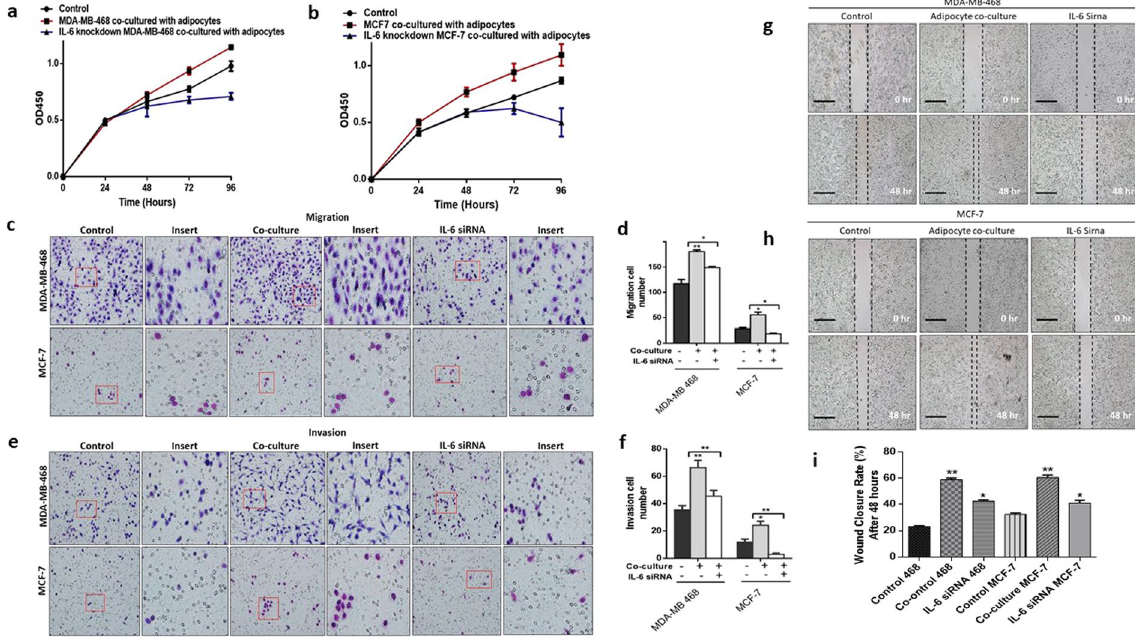
Figure 6. Blocking IL-6 signals reverses human adipocytes induced aggressive characteristics of breast cancer. ( a,b ) Proliferation capabilities of co-cultured breast cancer cells assessed in co-cultured breast cancer cells with/without IL-6 neutralization and in control cells. ( c ) Migration rate was examined using the transwell insert without matrigel in co-cultured breast cancer cells with/without IL-6 neutralization and in control cells. ( d ) Quantification of migration capabilities ability of in co-cultured breast cancer cells with/without IL-6 neutralization and in control cells. ( e ) Invasion rate in co-cultured breast cancer cells with/without IL-6 neutralization and in control cells. ( f ) Quantification of invasion capabilities in co-cultured breast cancer cells with/without IL-6 neutralization and in control cells. ( g, h ) Representative images of wound healing assay. Breast cancer cell motility accessed by a wound healing assay after 48 hours (magnification, x100), MDA-MB-468 and MCF-7 co-cultured breast cancer cells had a higher motility rates and blocking IL-6 inhibited breast cancer cell motility. ( i ) Quantification of breast cancer cell motility in co-cultured breast cancer cells with/without IL-6 neutralization and in control cells. All results are representative of 3 independent experiments. (Data indicate mean ± SD; *** p < 0.001; ** p < 0.01; * p <